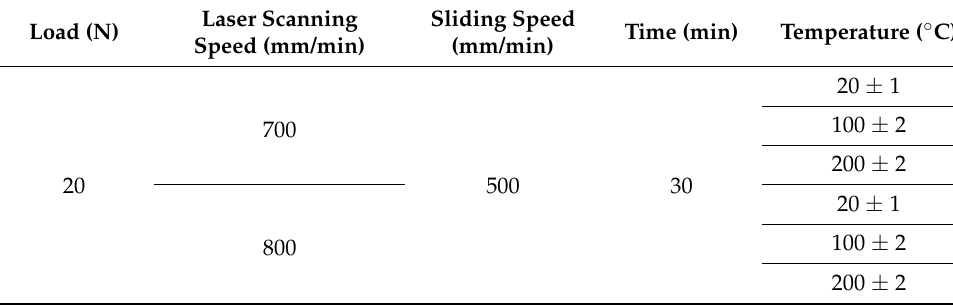
Table 3. Sliding speed effect experiment. Table 4. Temperature effect experiment.